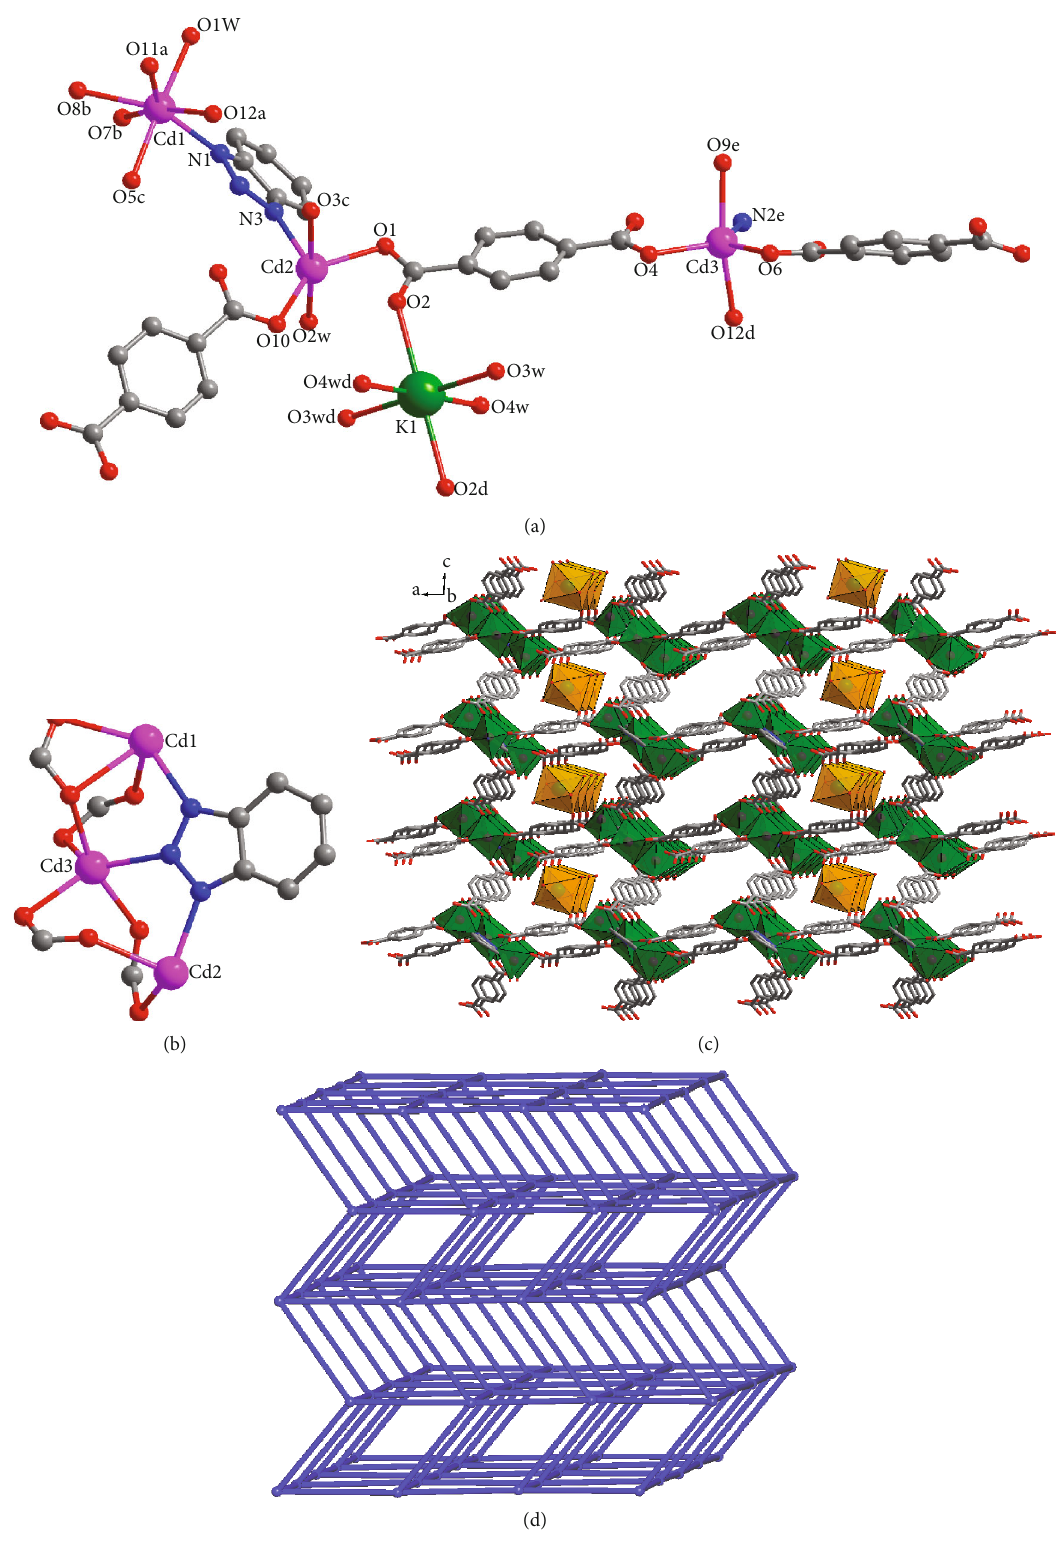
(btz)(COO) ] cluster-based building subunit for 1 . (c) The 3 4